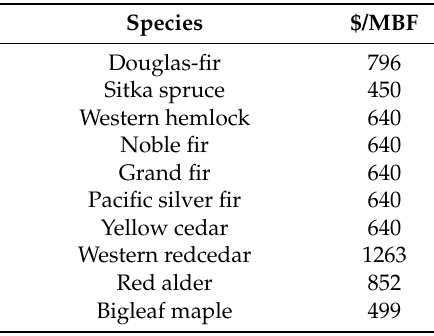
Table 2. Delivered log prices 1 .